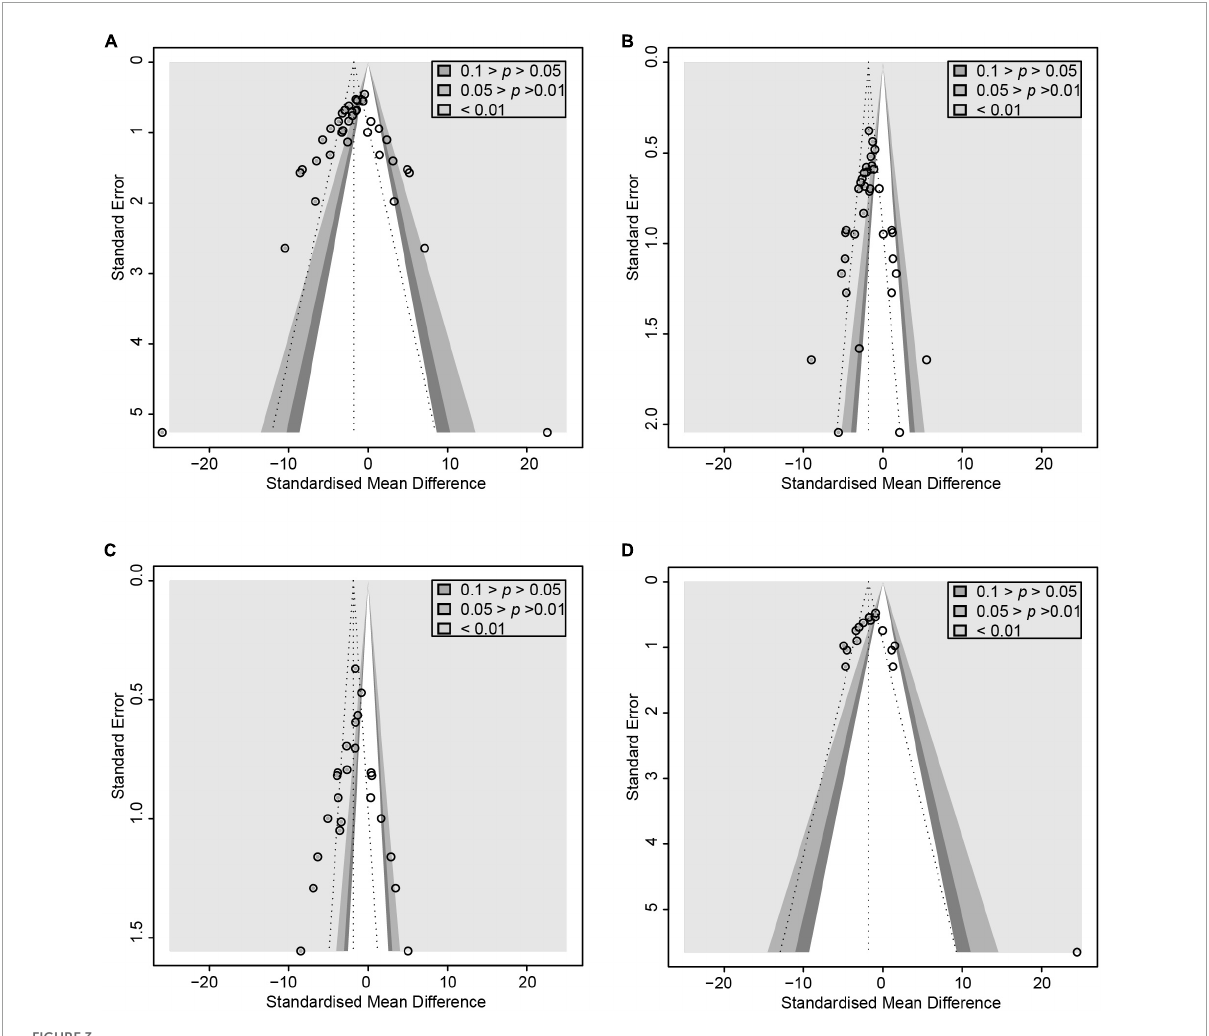
FIGURE3 Contour-enhanced funnel plot with trim-and-fill method. (A) ALT. (B) TG (C) TNF- α (D) Endotoxin. If the missing studies were in the non-significant area, the asymmetry was due to publication bias. Otherwise, the observed asymmetry could be attributed to factors other than publication